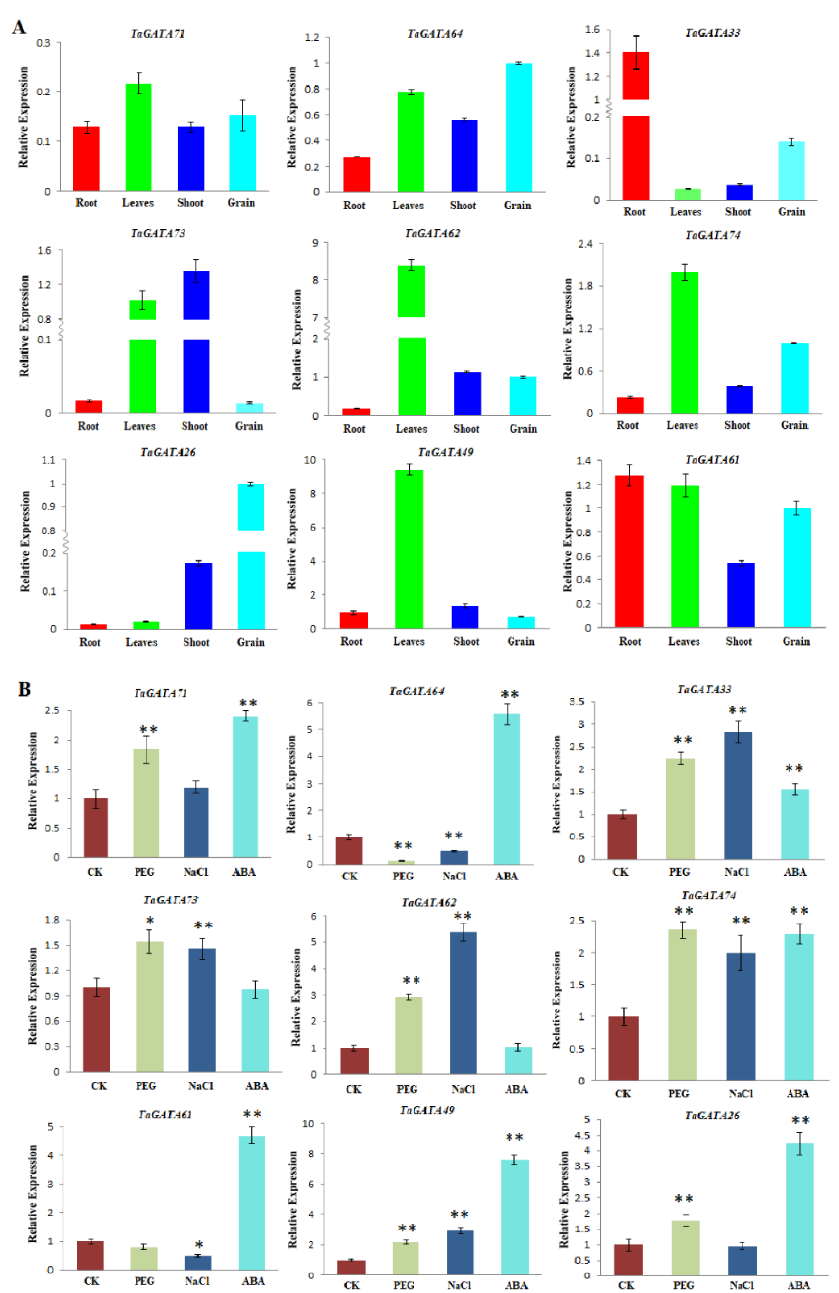
Figure 7. Expression analysis of nine wheat TaGATA genes by qRT-PCR. ( A ) Expression patterns of TaGATA genes in different organs. ( B ) Expression patterns of TaGATA genes under various abiotic stresses. Error bars represent standard deviations for three replicates. * p < 0.05; ** p < 0.01. Wheat GATA genes generally showed significantly expression changes when sub- jected to drought, salt, and ABA treatments (Figure 7B). Five TaGATA genes ( TaGATA33